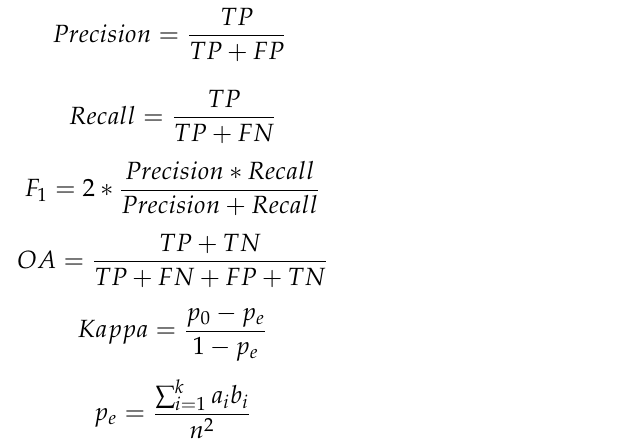
Figure 8. Process of integrating all spatial relationships. The SR represents the spatial relation and Obj represents the object. 2.7. Quality Assessment To reflect the performance of our proposed method, a pixel-based accuracy calcula- tion assessment method was performed. All ground object classes in the reference image were considered positive classes, while the classes in the final classification image of the proposed method were predicted classes. A positive class may be predicted as positive (TP) or negative (FN). A negative class can likewise be predicted as being positive (FP) or negative (TN). Their combined indices included precision (also known as producer